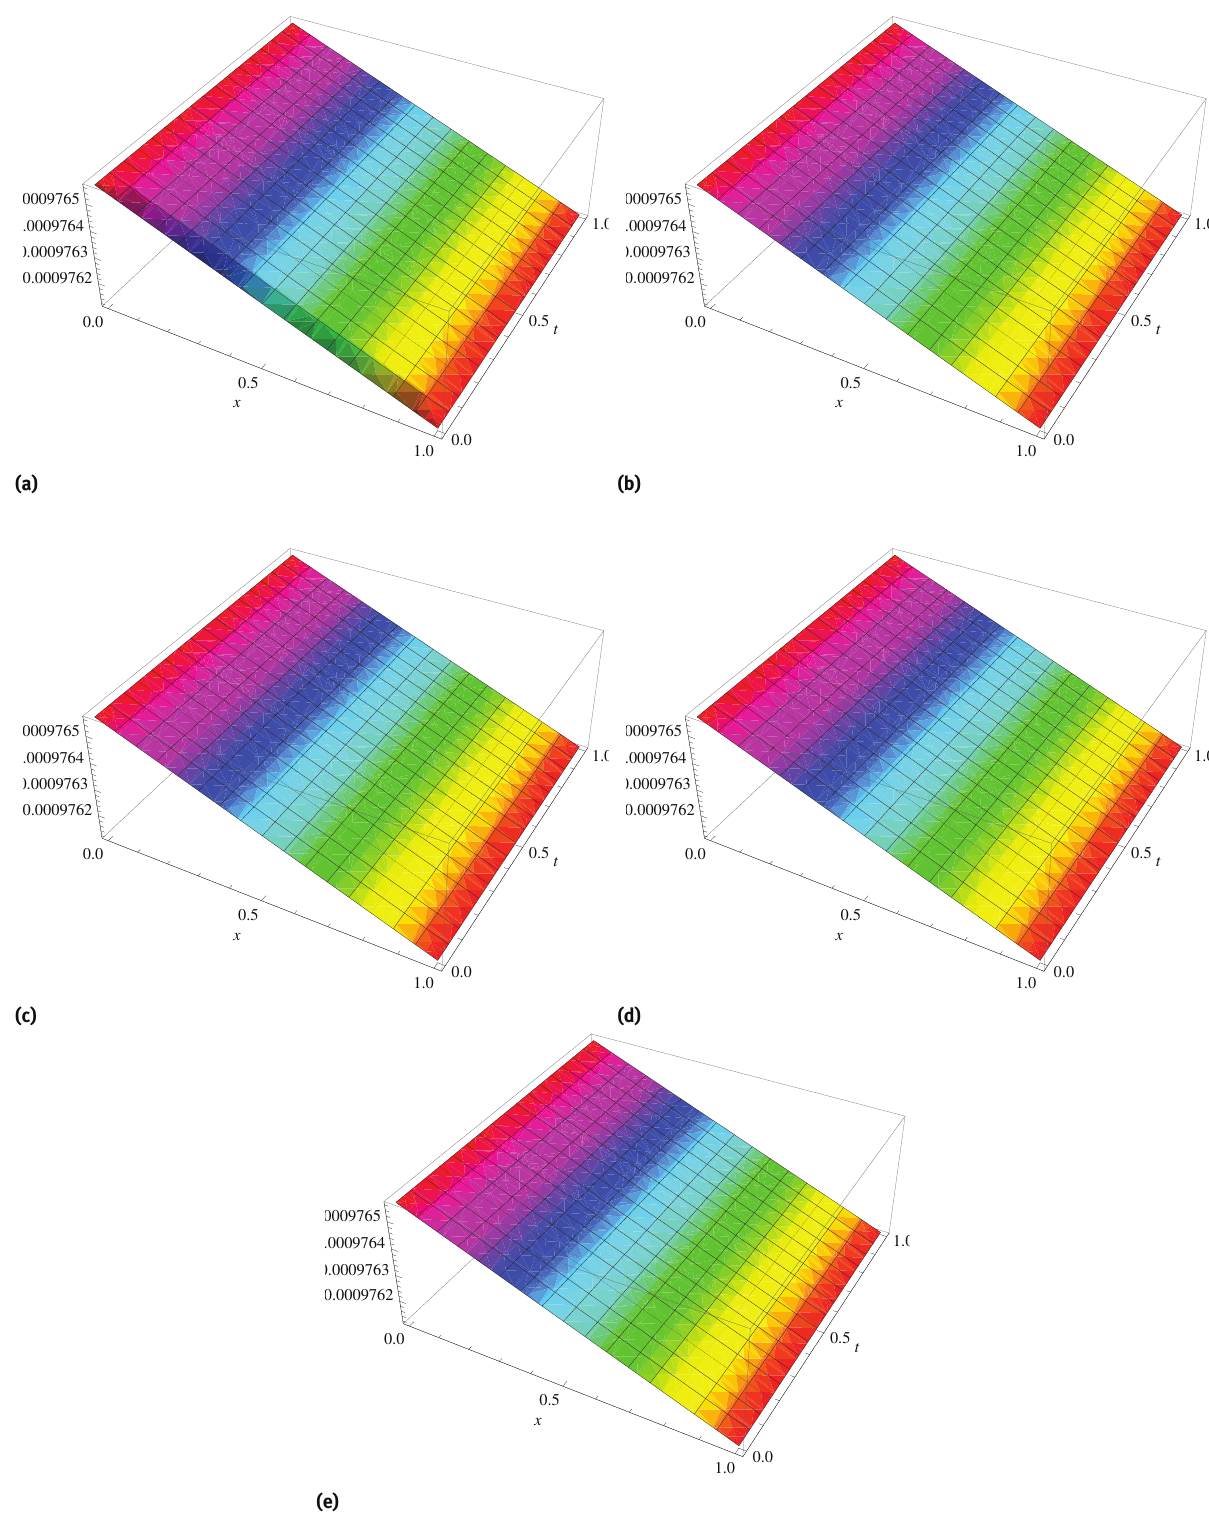
Fig. 9: Surface shows the 3rd order approximate solution of the time- fractional generalized Fisher equation: (a) u 3 ( x , t ) when α = 1 , (b) u 3 ( x , t ) when α = 0.75 , (c) u 3 ( x , t ) when α = 0.5 , (d) u 3 ( x , t ) when α = 0.25 , (e) exact solution u ( x , t ) when α = 1